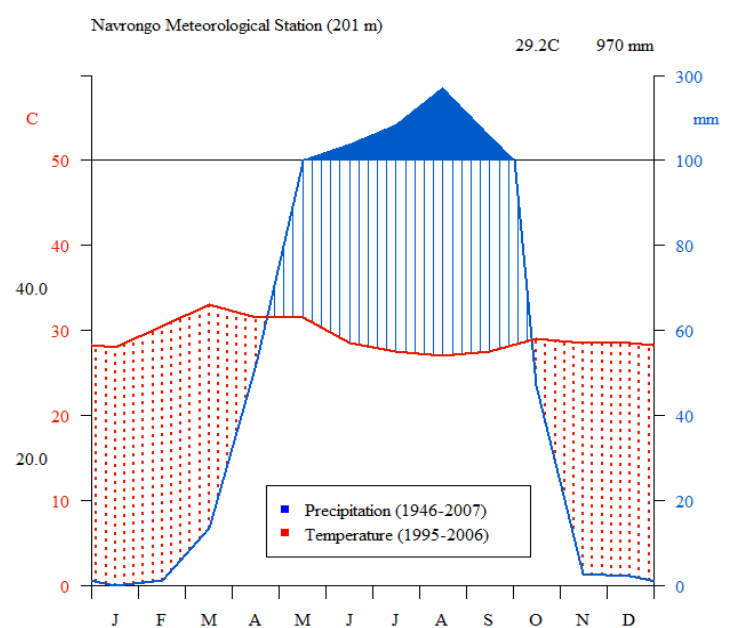
Figure 2. Walter–Lieth climate diagram for the Upper East region of Ghana based on data collected at Navrongo Meteorological Station (latitude 10°54 ′ 0 ″ N and longitude 1°06 ′ 0 ″ W; elevation 201 m above sea level). Precipitation data covered the period 1946–2007, and temperature data were measured between 1995 and 2006. Top of the graph shows the long-term mean annual temperature and rainfall. The value at the top-left of the temperature axis is the mean of the average daily maximum temperature of the hottest month; the value at the bottom of the same axis is the mean of the average daily minimum temperature of the coldest month. Area shaded in blue indicates the moist period and area shaded in red show the arid period. Area filled in blue indicates the period of excess water.